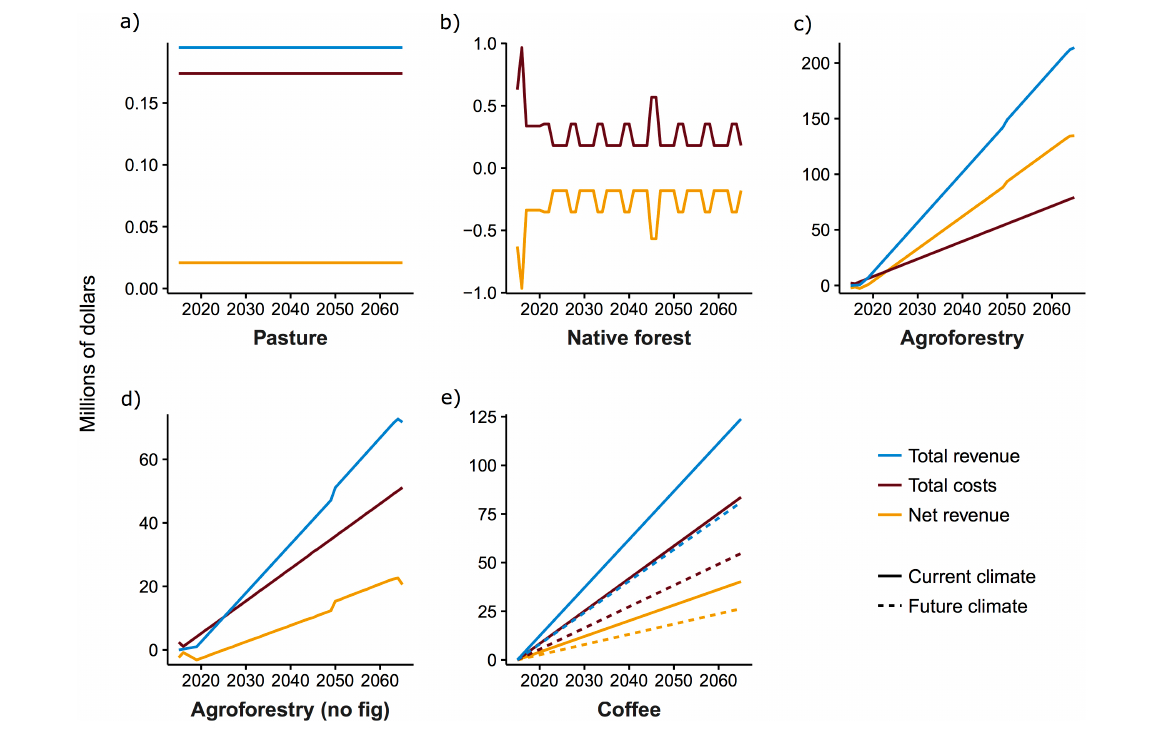
Fig. 5. Annual revenue and costs through time for (a) pasture; (b) native forest; (c) agroforestry (with figs); (d) agroforestry (no figs); and (e) coffee under current climate (solid line) and under climate change (dotted line).